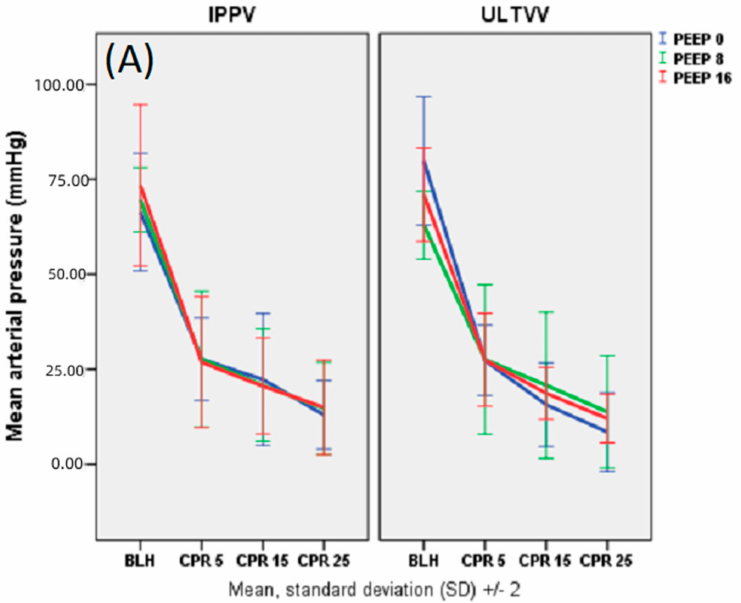
Figure 3. Haemodynamics: mean arterial pressure (MAP, ( A ) The unit of MAP is mmHg. Data are shown as mean values and standard deviation (SD). No significant differences were